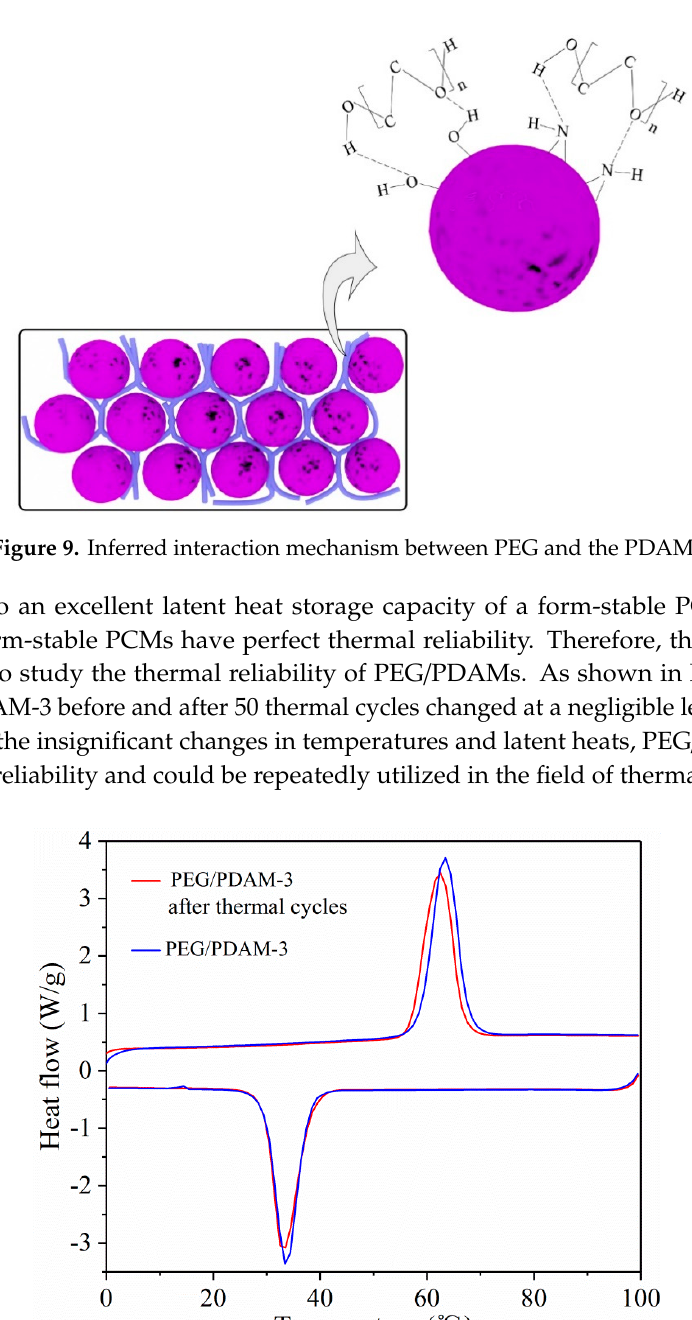
Figure 10. DSC curves of PEG/PDAM-3 before and after the thermal cycle.